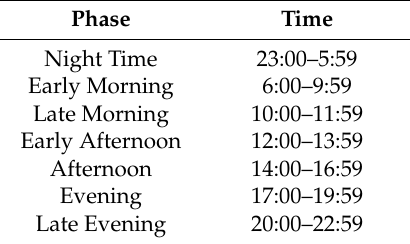
Table 1. Segmentation of day-time (24 h) into time segments ( Times of the Day